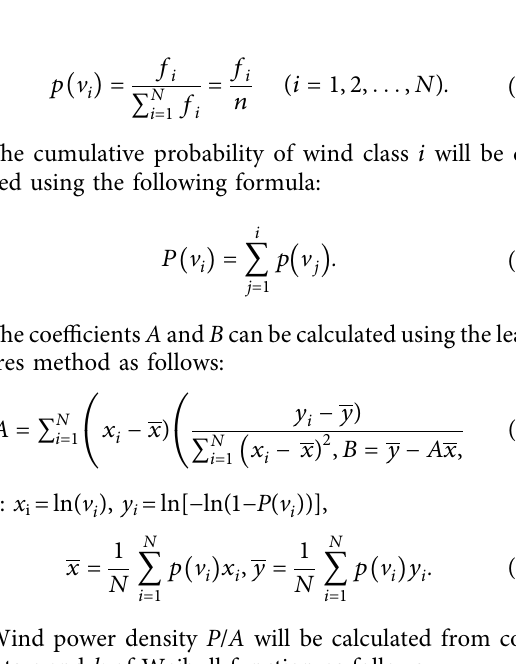
Figure 3: The values of α as a function of wind speed (a), and (b) scatter plot of model vs. observed wind speeds (m s − 1 ) for before bias correction (red) and after bias correction